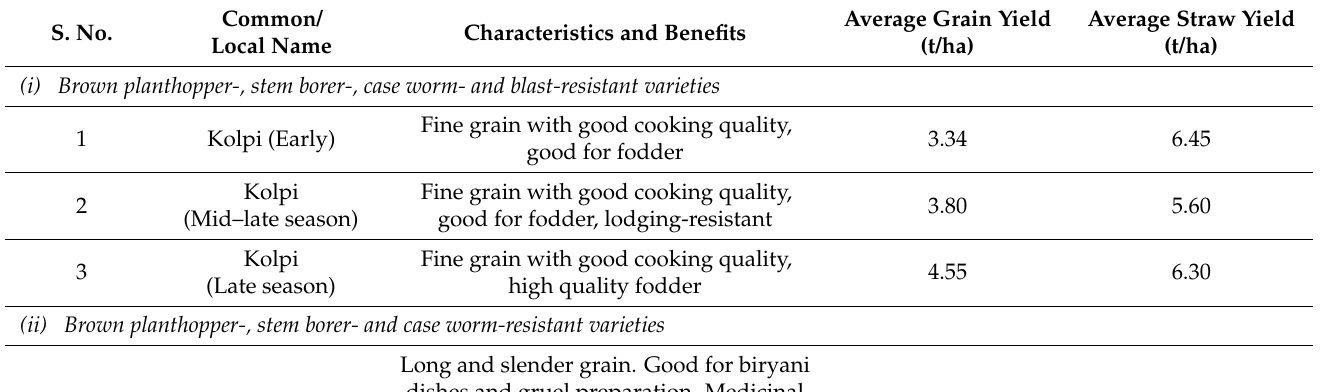
Table 2. Major characteristics and yield of traditional rice varieties in Palgar district of Maharashtra in Western Ghats Region of India